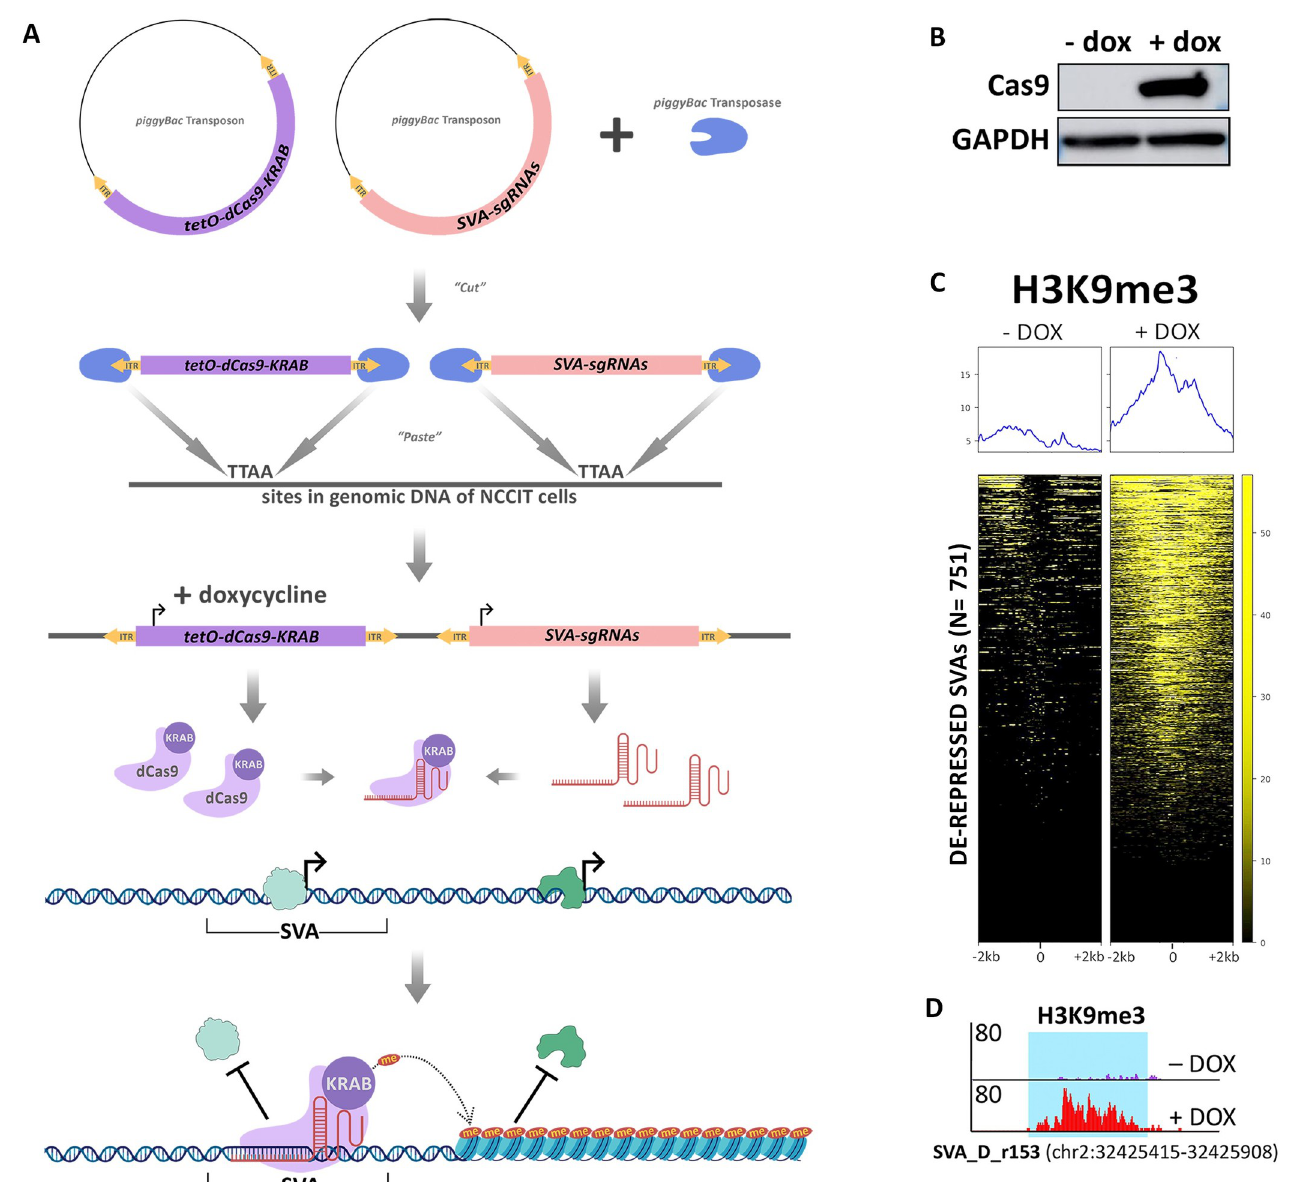
Fig 3. Epigenetic manipulation of NCCITs via CRISPRi results in SVA repression. (A) Schematic of the generation of the SCi-NCCIT line (created with BioRender.com). (B) Cas9 immunoblot displaying activation of dCas9-KRAB 72 hours post-doxycycline induction. (C) H3K9me3 ChIP-seq heatmap of the SCi-NCCITs shows increased H3K9me3 signal post-doxycycline treatment. (D) Genome browser screenshot displaying increased H3K9me3 before and after treatment with doxycycline at a de-repressed SVA-D.